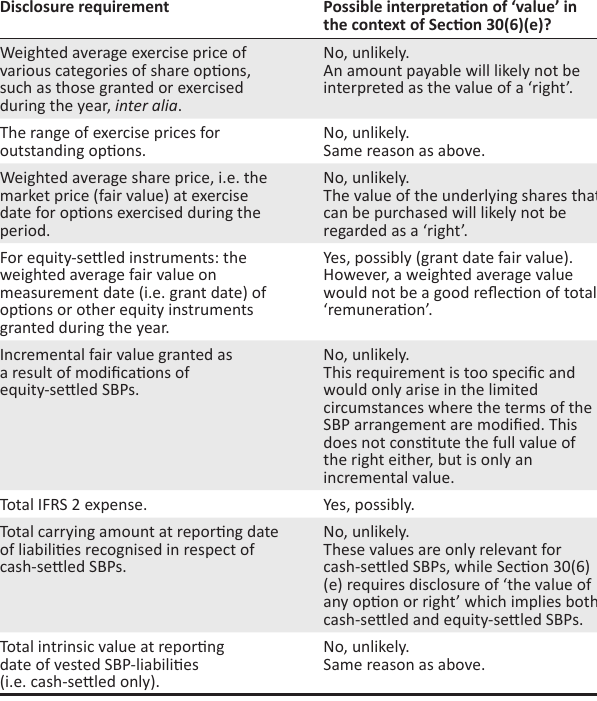
TABLE 5: IFRS 2 disclosure requirements and applicability to Section 30(6)(e).